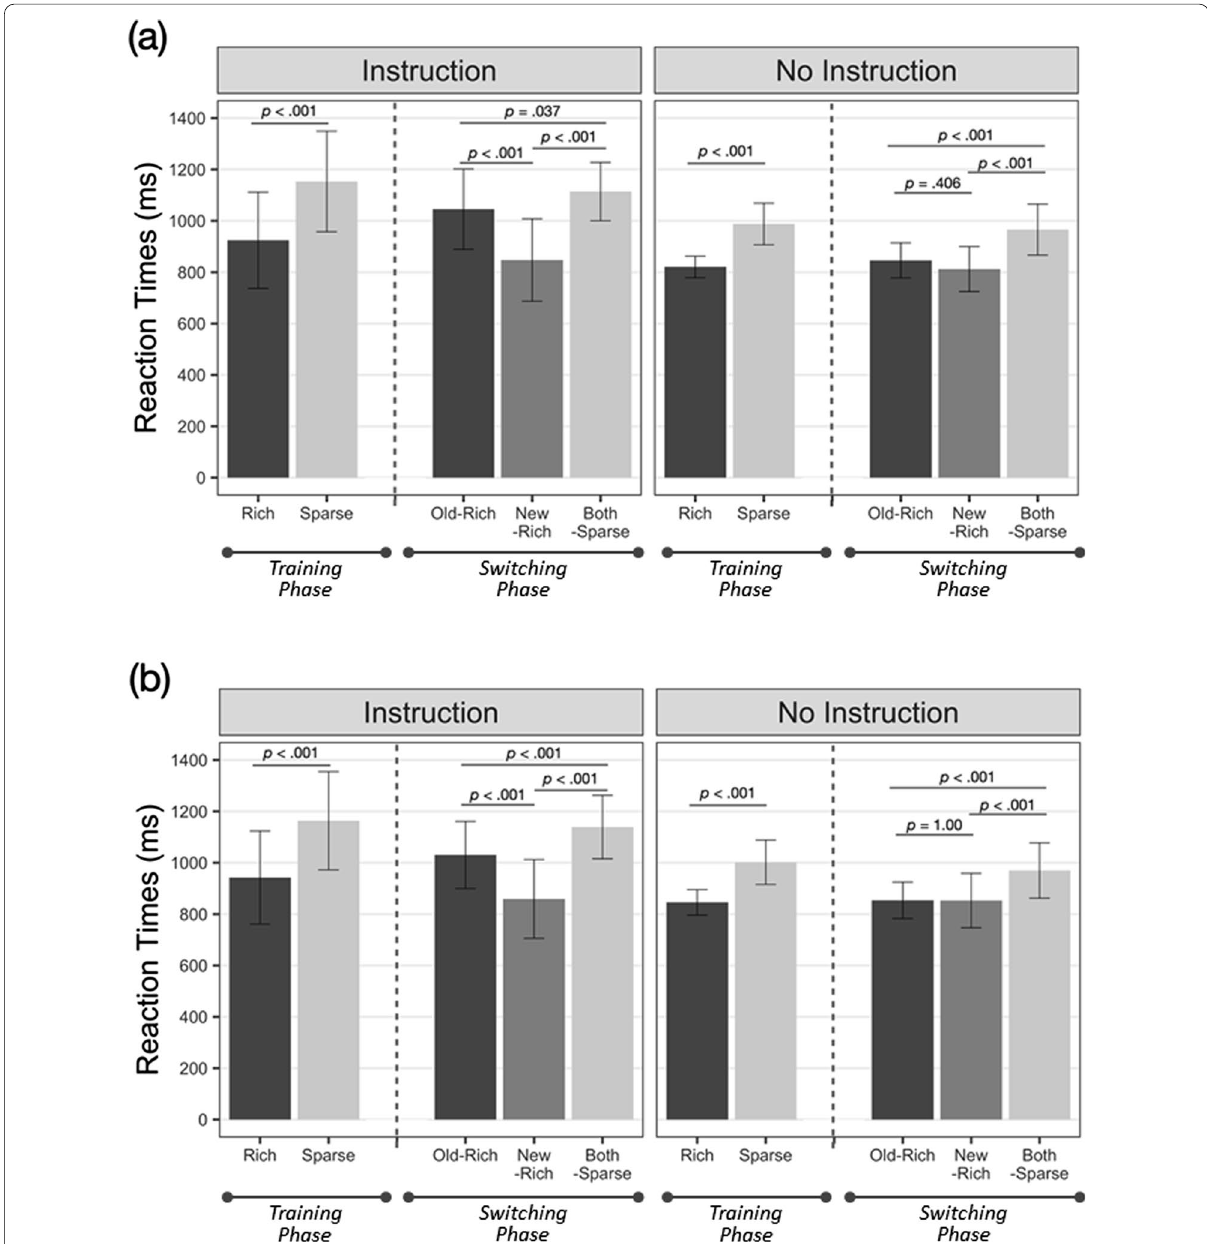
Fig. 2 Mean RTs of instruction group and no‑instruction group. Note : a RTs of datasets whose awareness score was reflected ( N complete datasets whose awareness score was not reflected ( N can be found in Additional file 1: Table